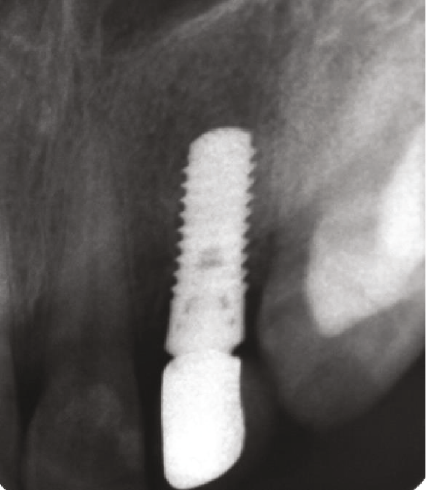
Figure 7: 1-year